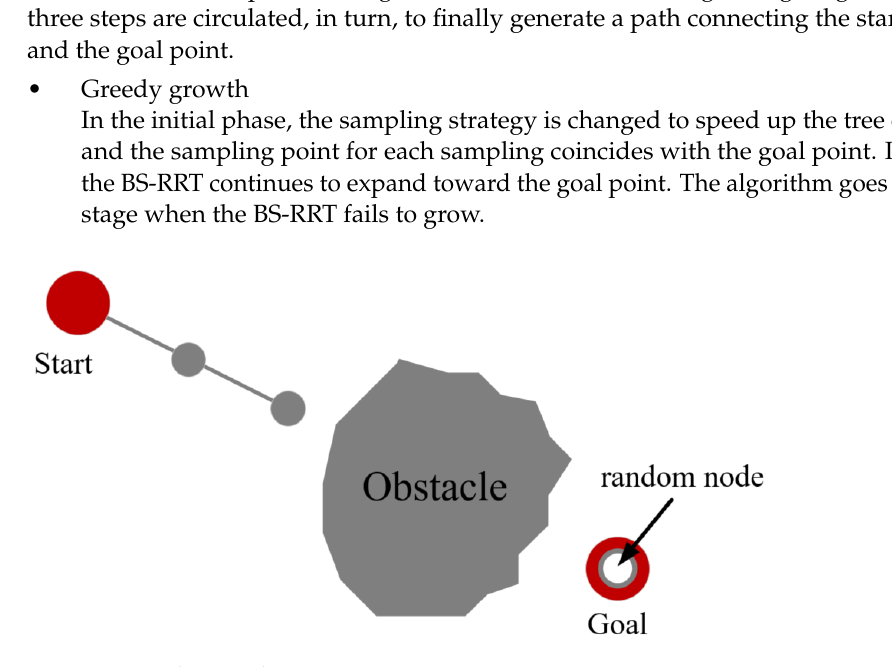
Figure 2. Greedy